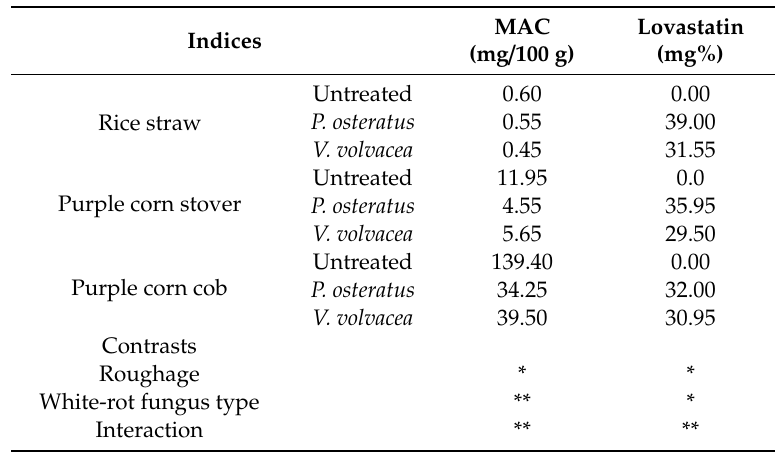
MAC Lovastatin (mg / 100 g) (mg%)